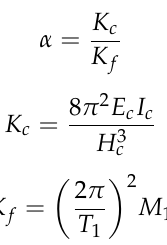
Figure 13. Modified Ibarra–Medina–Krawinkler model.